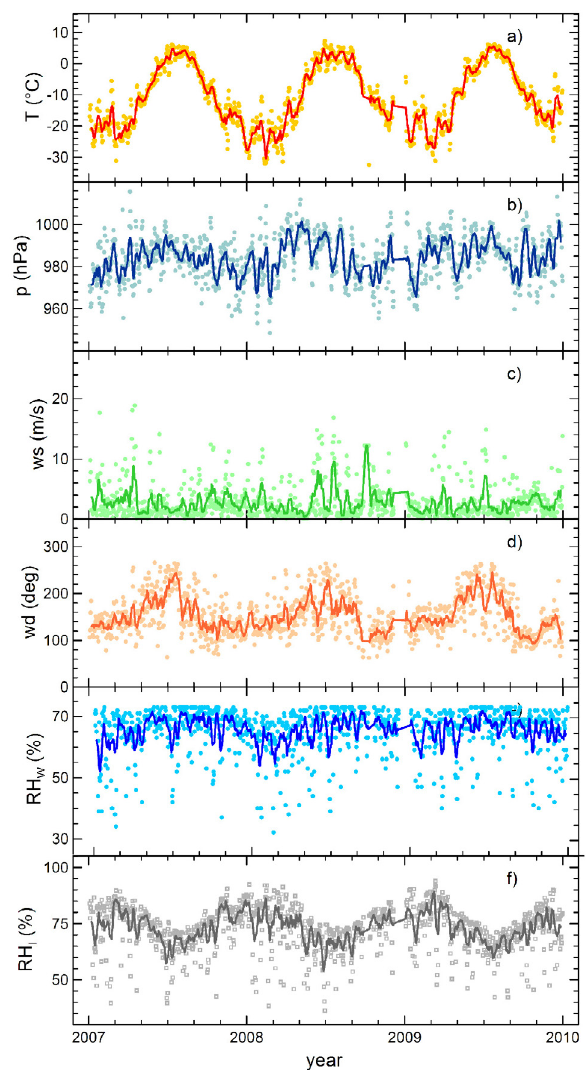
Figure 8. Daily means of: (a) air temperature, T; (b) surface pressure, p; (c) wind speed, ws; (d) wind direction, wd; (e, f) relative humidity , and ice, RH , measured at Thule in the with respect to water, RH W I period 2007-2009. 10-day running means (solid lines) are also